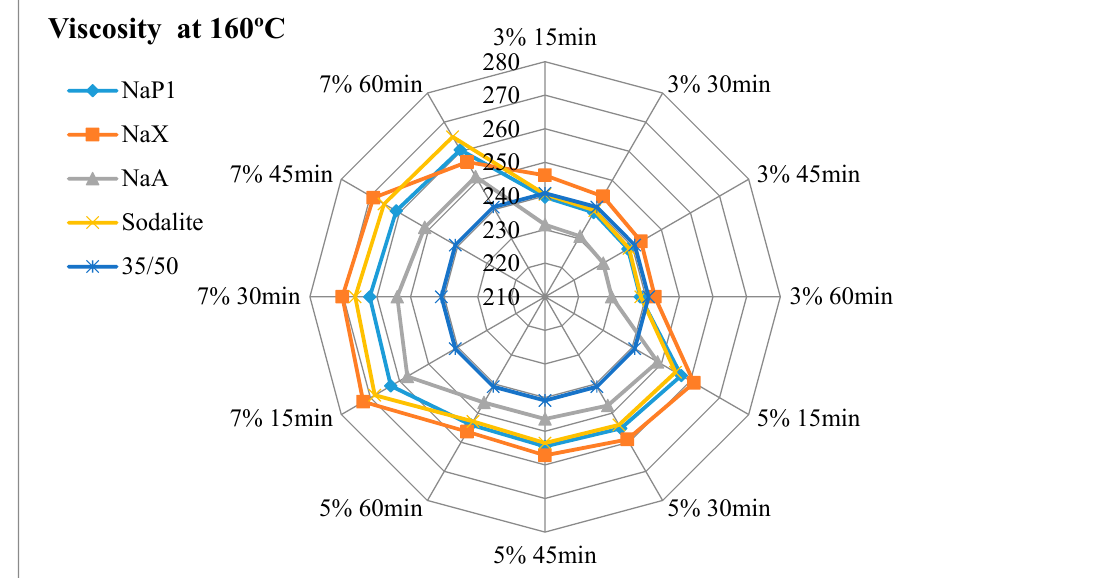
Figure 5. The results of dynamic viscosity tests for 35/50 asphalt with the addition of zeolites measured at 160 °C.